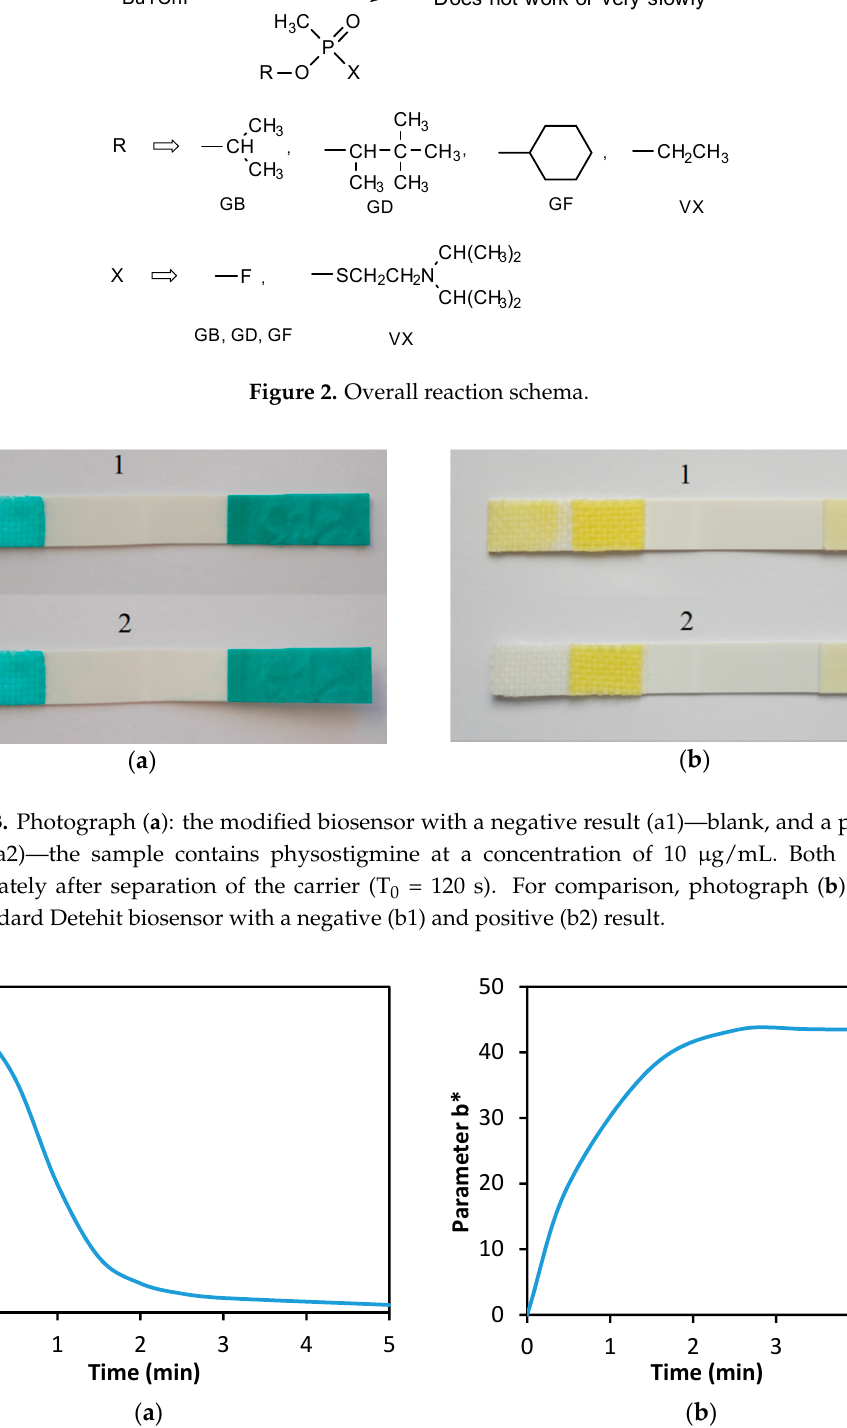
Figure 4. Dependence of the indicator zone color intensity on time (min): ( a ) the modified biosensor (Guinea Green B), ( b ) a standard Detehit biosensor (Ellman’s reagent).